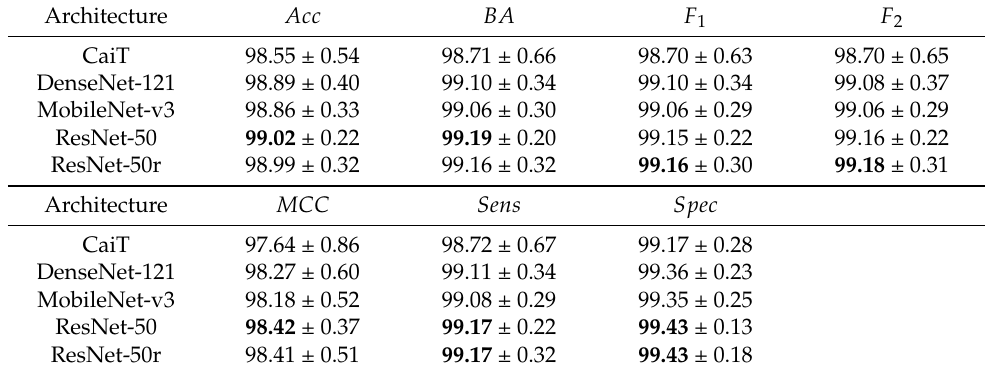
Table 6. Evaluation metrics by architecture before bootstrapping. Best results are highlighted in bold.